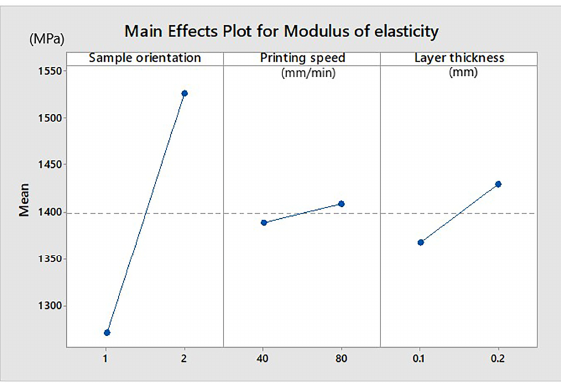
Figure 3. Influence of parameters on modulus of elasticity (Extrudr BDP Flax samples). Sample orientation: 1—plan and 2—on edge.